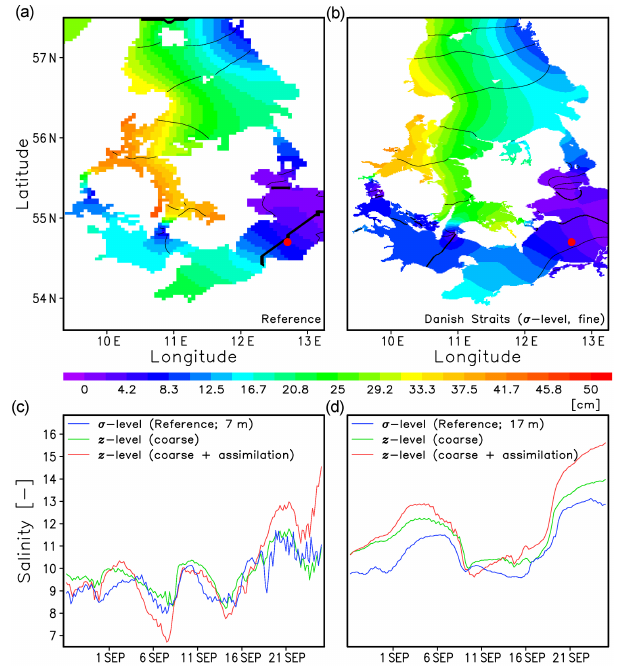
Figure 4. Tidal amplitude (in colors) and phase lines (the distance between individual lines is 40 ◦ ) in the transition zone simulated in the reference model (a) and the fine-resolution nest (b) . (c) and (d) show the temporal change of salinity at 7m (c) and 17 (d) in a location in the Dars Sill, which is identified by the red symbol in (a) and (b) . The legend explains the individual